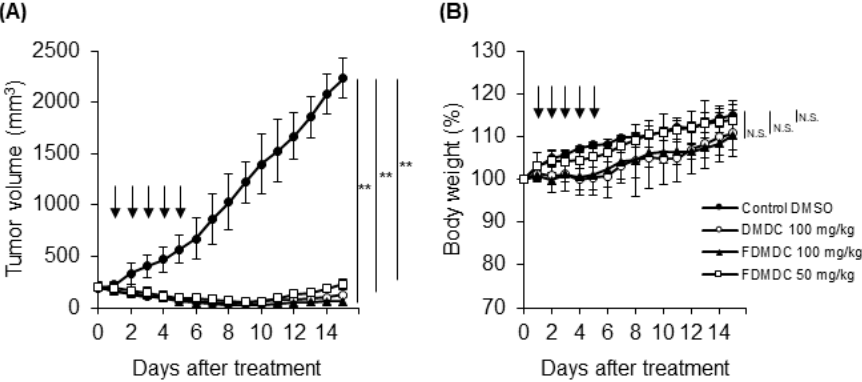
Figure 3. FDMDC and DMDC suppressed tumor growth of ATL cell lines inoculated into NOG mice in vivo. NOG mice were subcutaneously inoculated with 3 × 10 7 TL-OmI cells. After tumor size reached approximately 150–250 mm 3 , the indicated doses of FDMDC (n = 8), DMDC (n = 8), or control DMSO (n = 8) were intraperitoneally administered into the mice daily for 5 days (as indicated by arrows). Tumor size ( A ) and body weight ( B ) were measured daily. For ( A ) and ( B ), bars indicate mean values ± standard error of the mean for the eight mice in each group obtained from among two independent experiments. Statistically significant differences are shown as p values (**; p < 0.01). N.S., no significant difference.